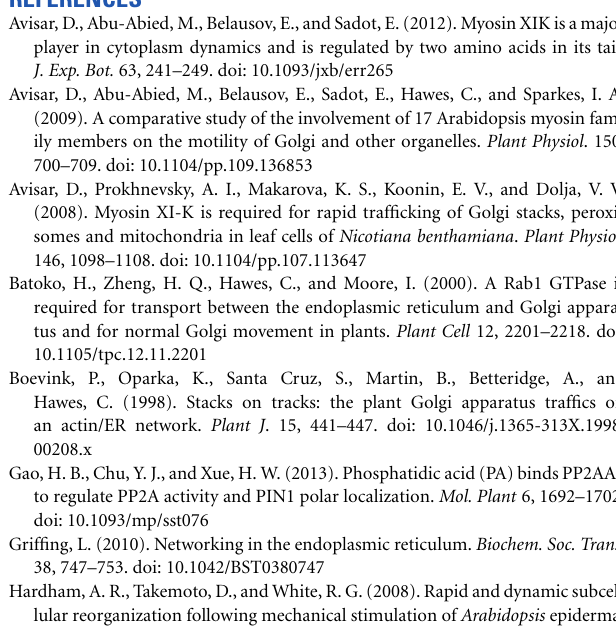
Figure S3 | Histogram of the percent of each persistent cisternae in different size classes for each treatment. The distribution of the percentage that each different size class makes to the population of persistent cisternae produced by each treatment is shown. The value of each size class was chosen so that comparisons could be made between those that had predominantly small cisternae (e.g., control) and those that had very large cisternae (e.g., XI-1 and XI-K). Figure S4 | Relative movement or flow as shown by average displaced frame differences summed over imaged volumes. The value of the intensity difference between every fifth frame, the displaced frame difference, is summed for each movie and divided by the approximate volume of the region imaged (area of signal in a 3 µ m optical section). The average of these values is shown for all of the movies acquired for each treatment. Error bars are standard deviation. XI-1, XI-C, XI-E, XI-K, and XI-I are significantly different to the control ( p < 0 . 005; Tukeys HSD comparison of means), and to XI-A ( p < 0 . 05; Tukeys HSD comparison of means), and XI-1, XI-C, XI-E, and XI-K are significantly different to XI-2 ( p < 0 . 05; Tukeys HSD comparison of means).